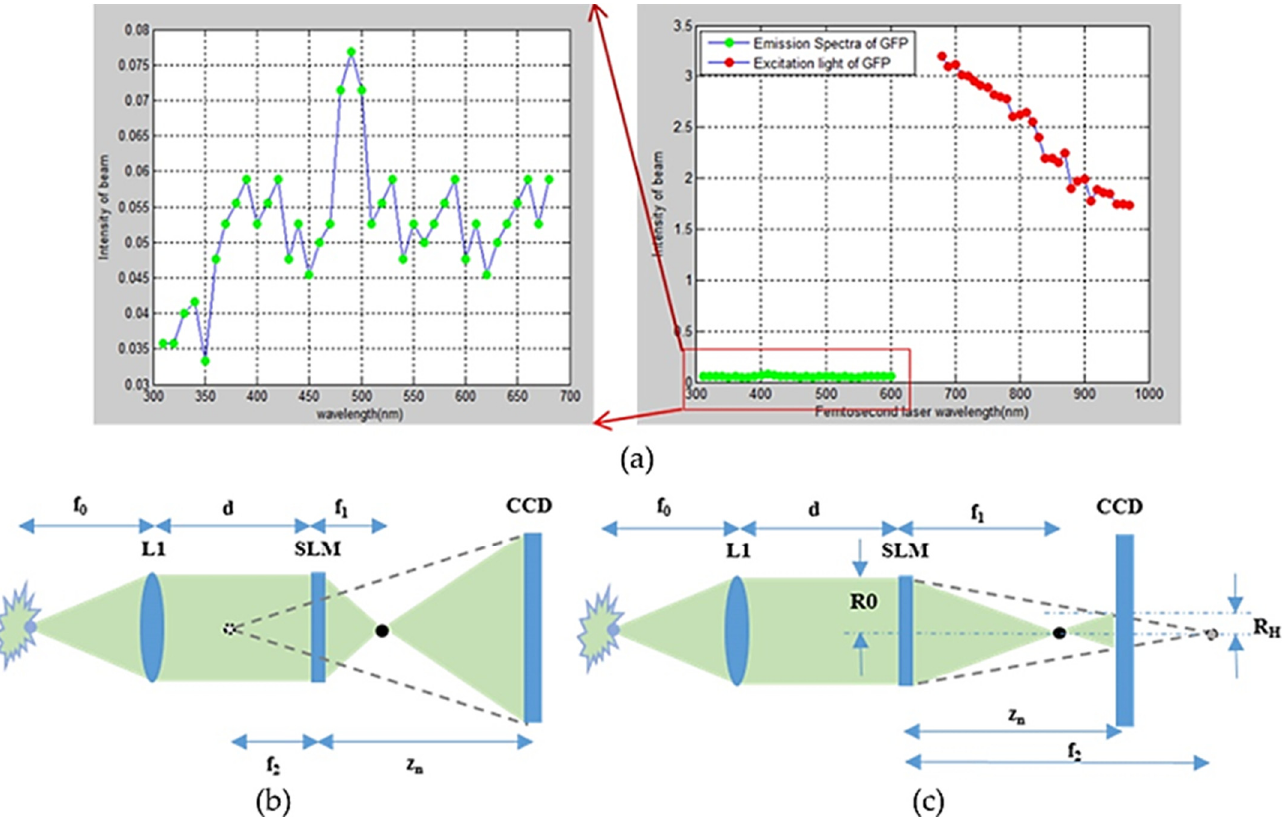
Figure 19. ( a ) Excitation and emission spectra of the living cell, FINCH with two diffractive lenses: ( b ) one is positive, and the other is negative, and ( c ) both are positive (adapted from [39]).